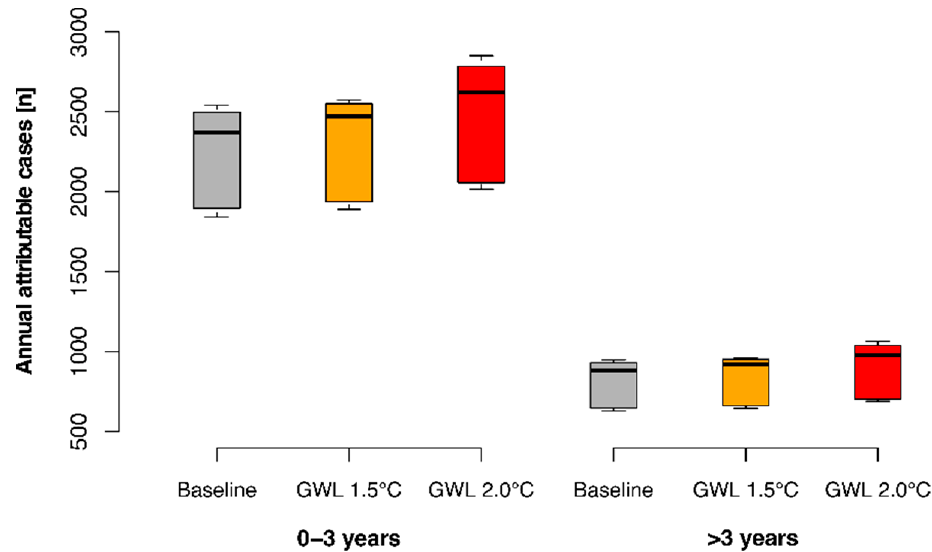
Figure 5. Annual number of diarrhoea cases attributable to heat (temperature > 19 °C) under current and future climate for age groups 0–3 years and >3 years.